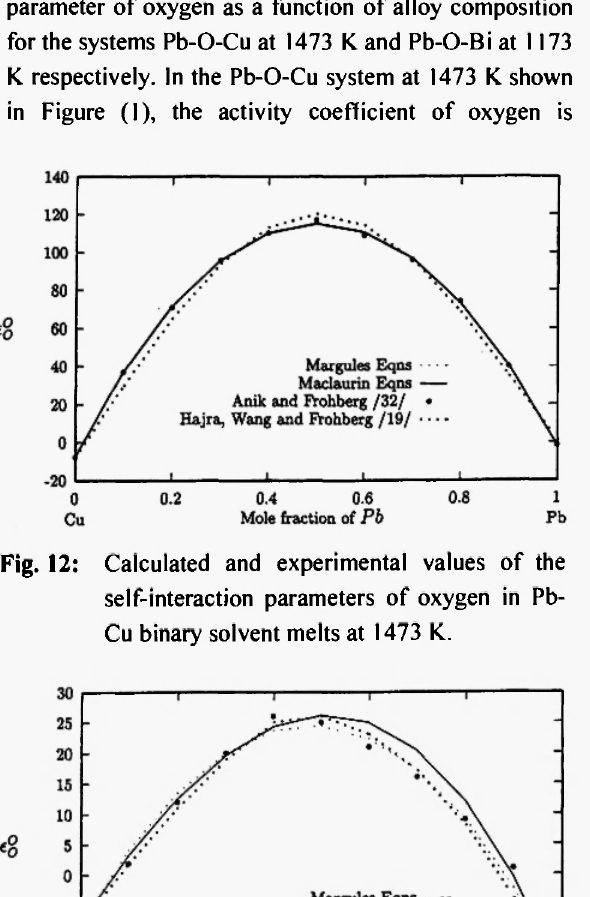
Fig. 12: Calculated and experimental values of the self-interaction parameters of oxygen in Pb- Cu binary solvent melts at 1473 K.